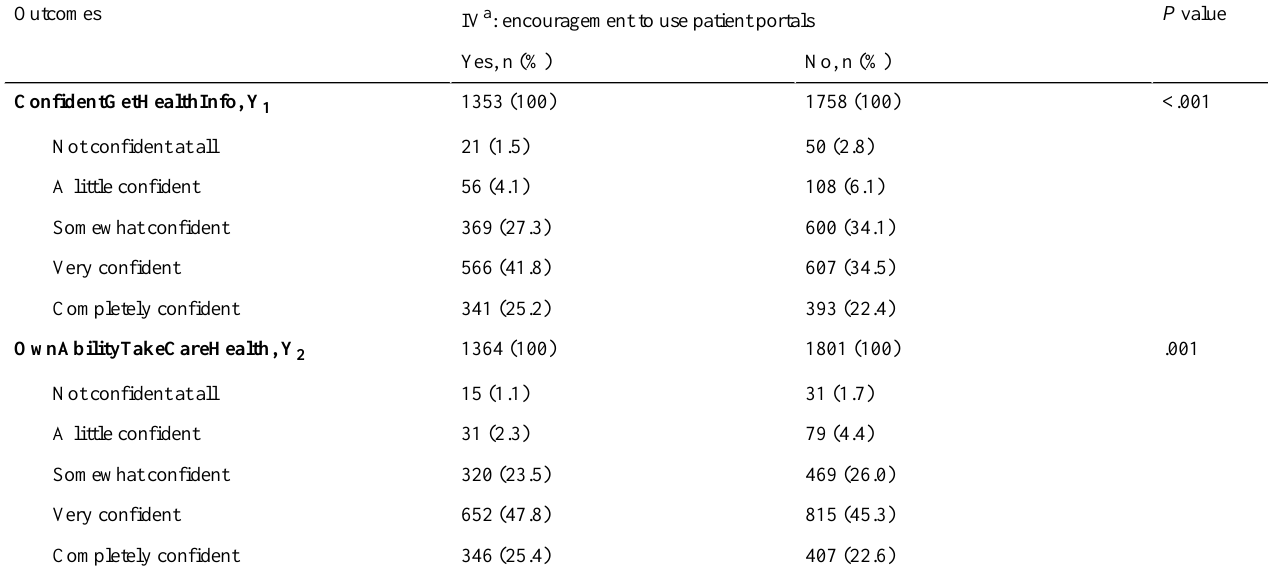
Table 1. Chi-square test results for the association between encouragement to use patient portals and self-efficacy outcomes.